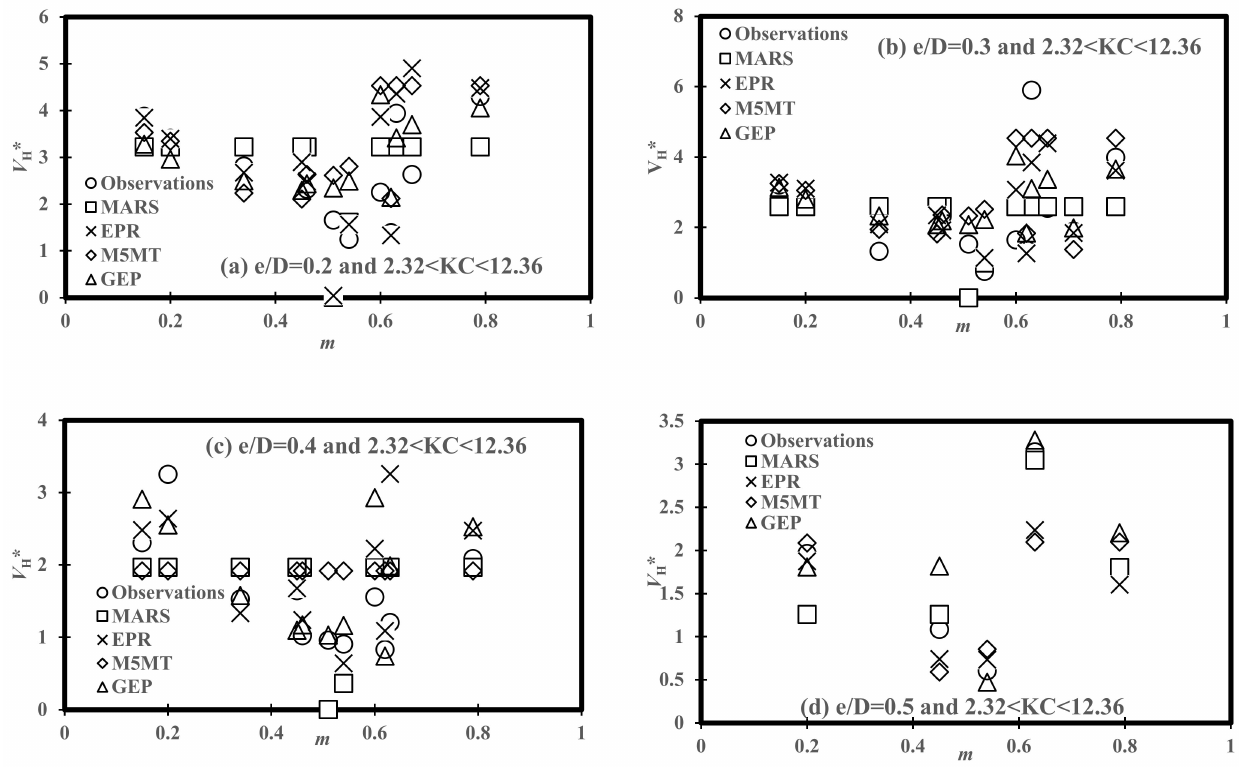
Figure 6. Comparisons of the soft computing models’ performance for variation of V H * versus m in for various levels of e / D : ( a ) e / D = 0.2, ( b ) e / D = 0.3, ( c ) e / D = 0.4, and ( d ) e / D = 0.5. Table 15. RMSE values for performance of the soft computing models for variation of velocity ratio. Variation of V H * vs. m for 2.32 < KC < Soft Computing Models